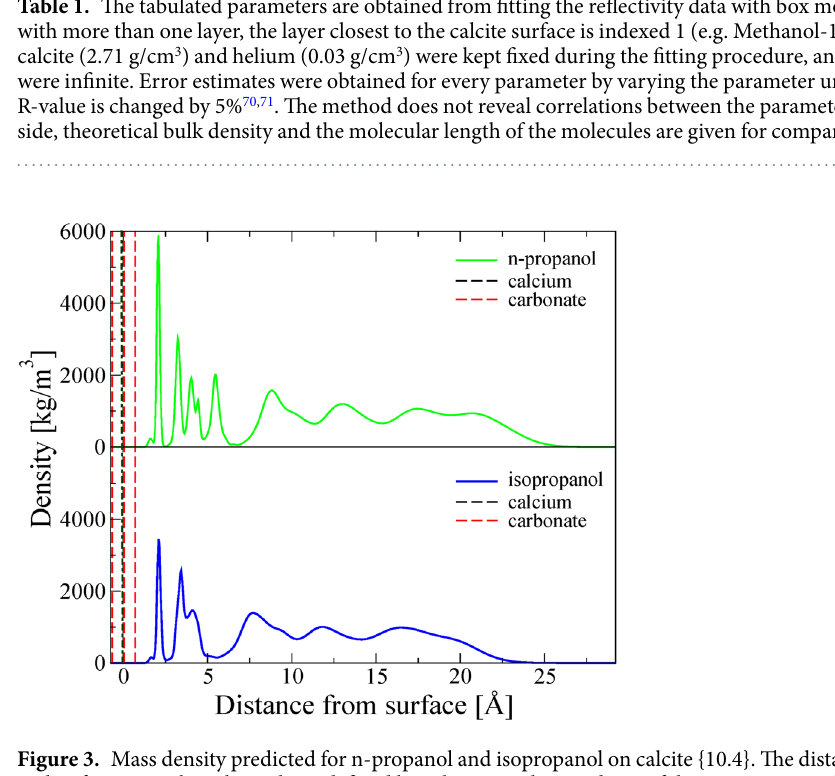
Figure 3. Mass density predicted for n-propanol and isopropanol on calcite {10.4}. The distances are recorded with reference to the calcite plane, defined by calcium, carbon and one of the oxygen atoms (black dashed line). For each carbonate ion, a second oxygen is above this plane and third is below (red dashed lines).